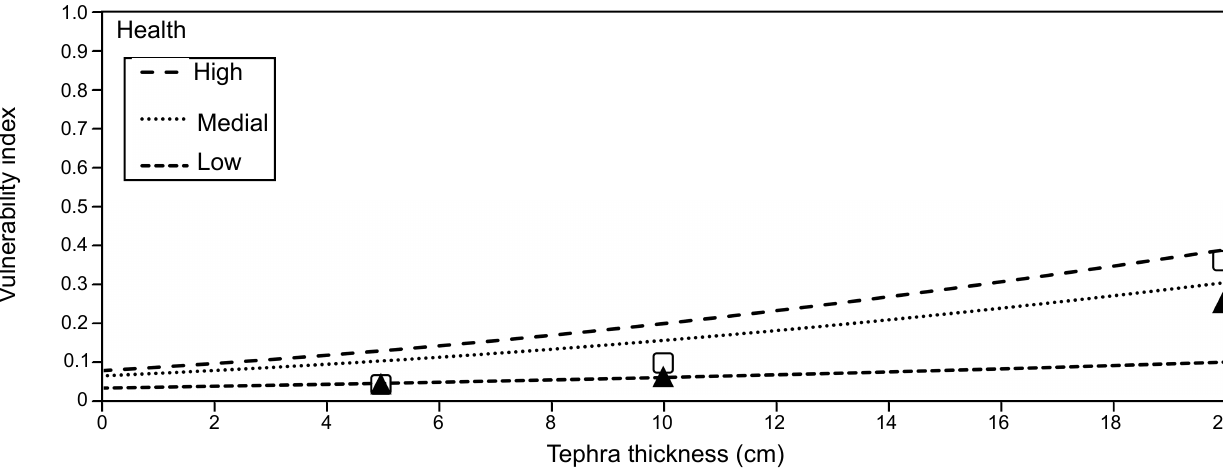
Figure A1: Estimated high, medial, and low health rates for a human Palaeolithic population exposed to 0–20 cm of tephra fall from the Laacher See eruption. Boxes = Participant A, Triangles = Participant B estimates of vulnerability for 5, 10, and 18–20 cm of compacted tephra. Table A1 – Fitting parameters for vulnerability curves based on health in Figure A1.